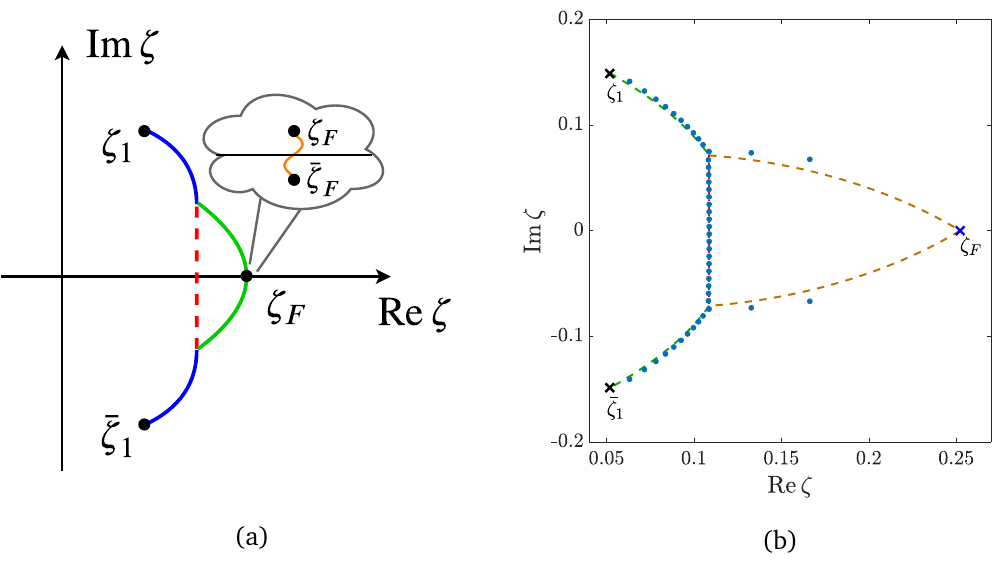
Figure 7: (a) Fluctuation point ζ , lying on the real axis, can be viewed as an in- F finitesimal (collapsed) branch cut – a deactivated mode. (b) Comparison between the classical contour (dashed line) with anisotropic parameter δ = 1, filling fraction ν = 0.3, and mode number n = 1 (computed based on reality condition (6.3)) with a condensate (red dashed line) and an additional contour originating from ζ dashed line) and the corresponding solution to the Bethe equations (cf. Eq. (3.3)) (cid:112) δ = 1 with M = 48, L = 144 and η = (blue dots). Notice that the Bethe roots L 144 ϑ (cid:112) plotted are tan δ